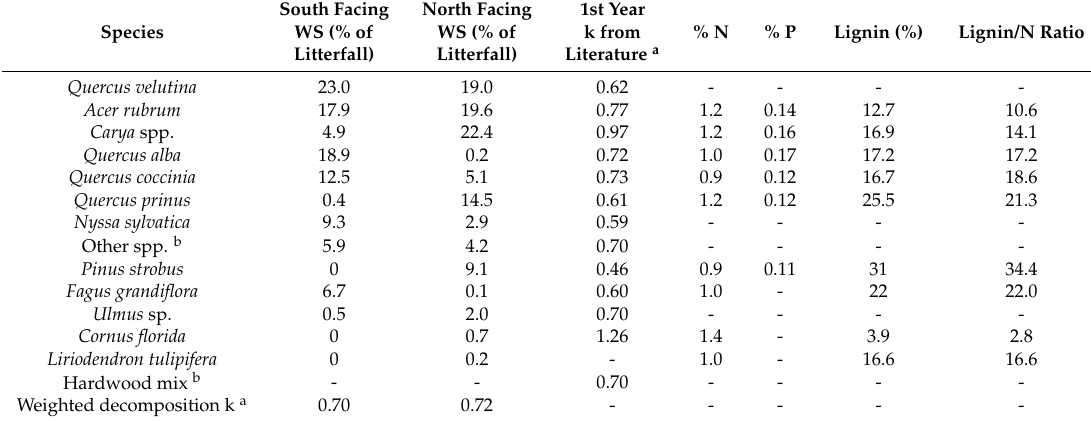
Table 7. Species composition in litterfall on the two deciduous watersheds and the inferred similarity of the mixture of species specific decomposition rates found by Cromack and Monk [18] on the North facing deciduous WS as indicated by the “weighted decomposition